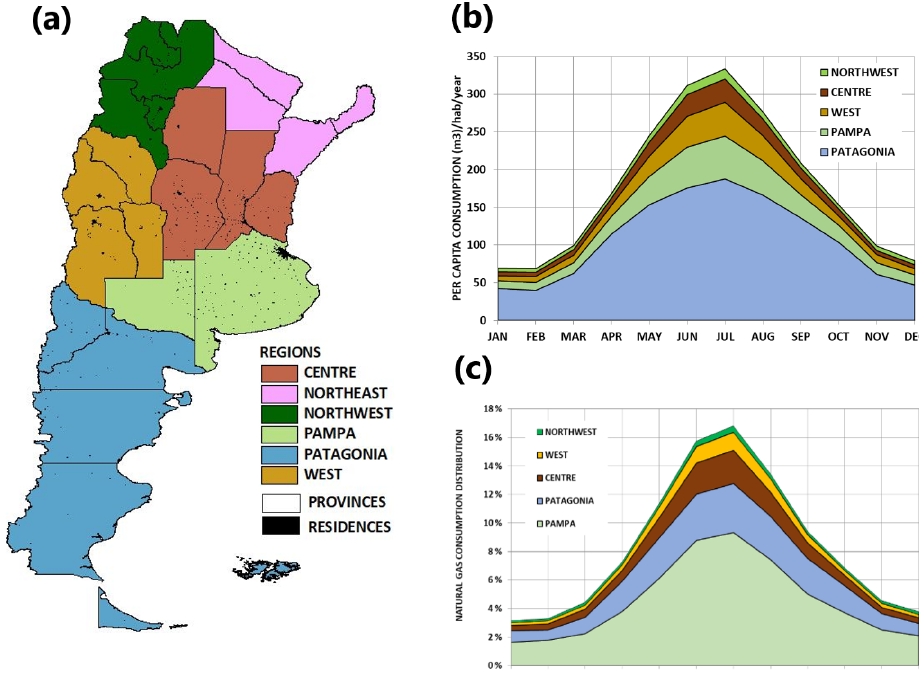
Figure A3. (a) Regions and provinces with natural gas consumption at homes. (b) Per capita annual natural gas consumptions. (c) Regional and seasonal distribution of natural gas consumption per region (percent of total annual consumption).